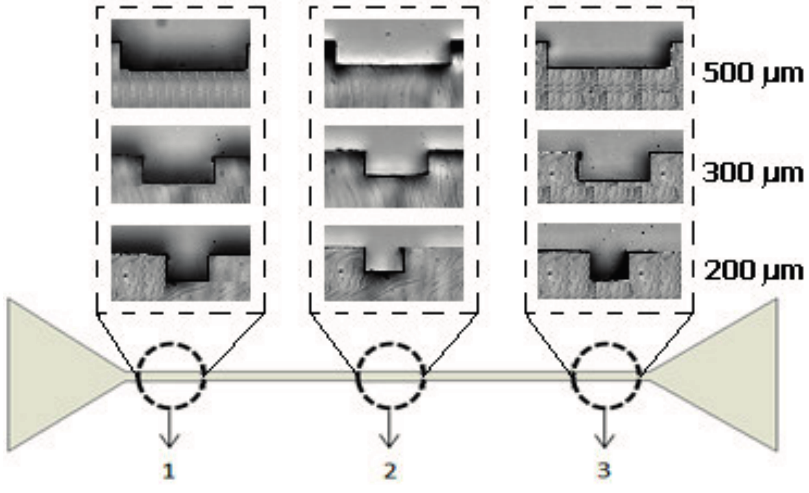
Figure 6. Schematic representation of the microchannel geometry and location of the sections where the microscopic images were collected to evaluate the geometrical